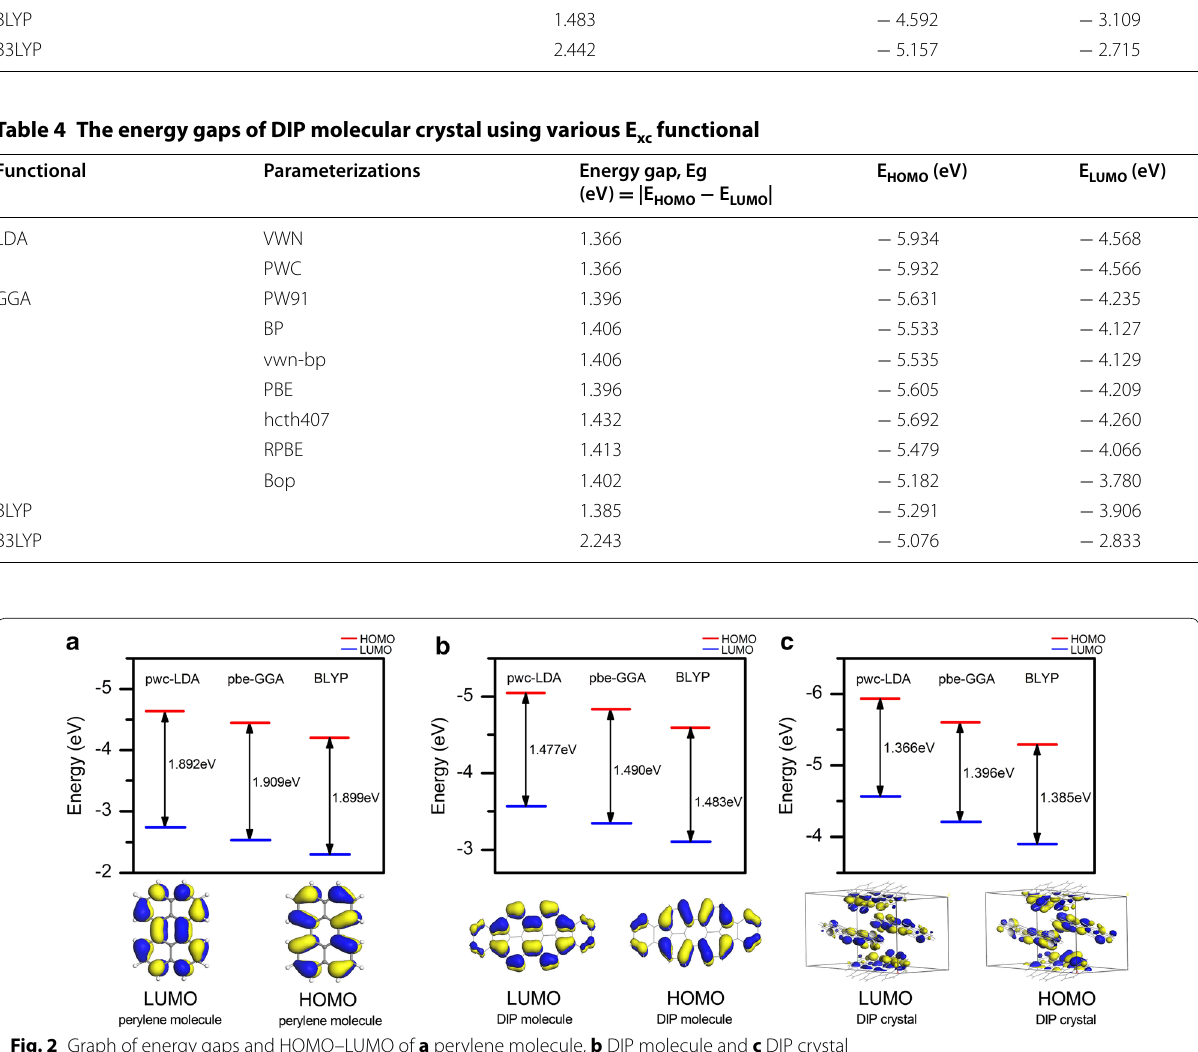
Table 3 The energy gaps of isolated DIP molecule using various E Functional